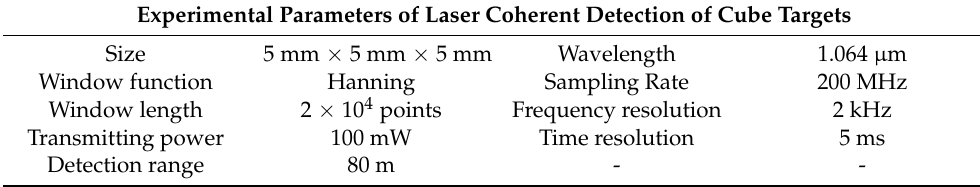
Table 3. Experimental parameters of laser coherent detection of cube